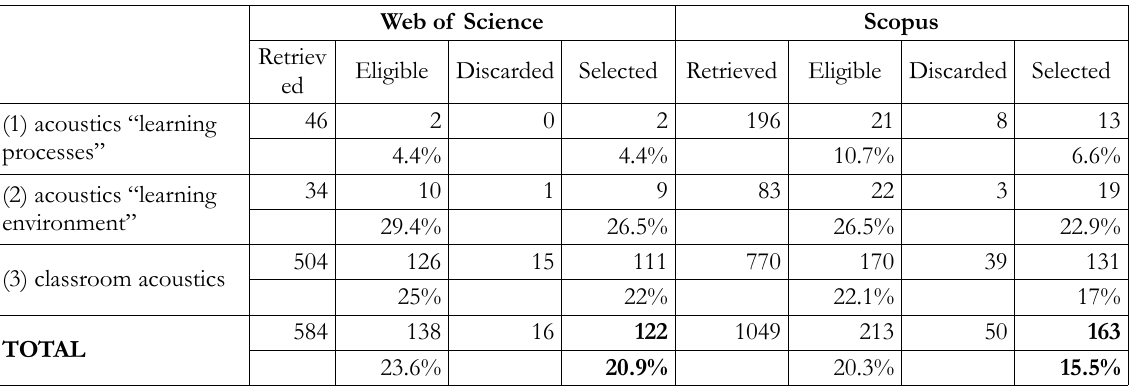
Table 1. Results from the literature search in both